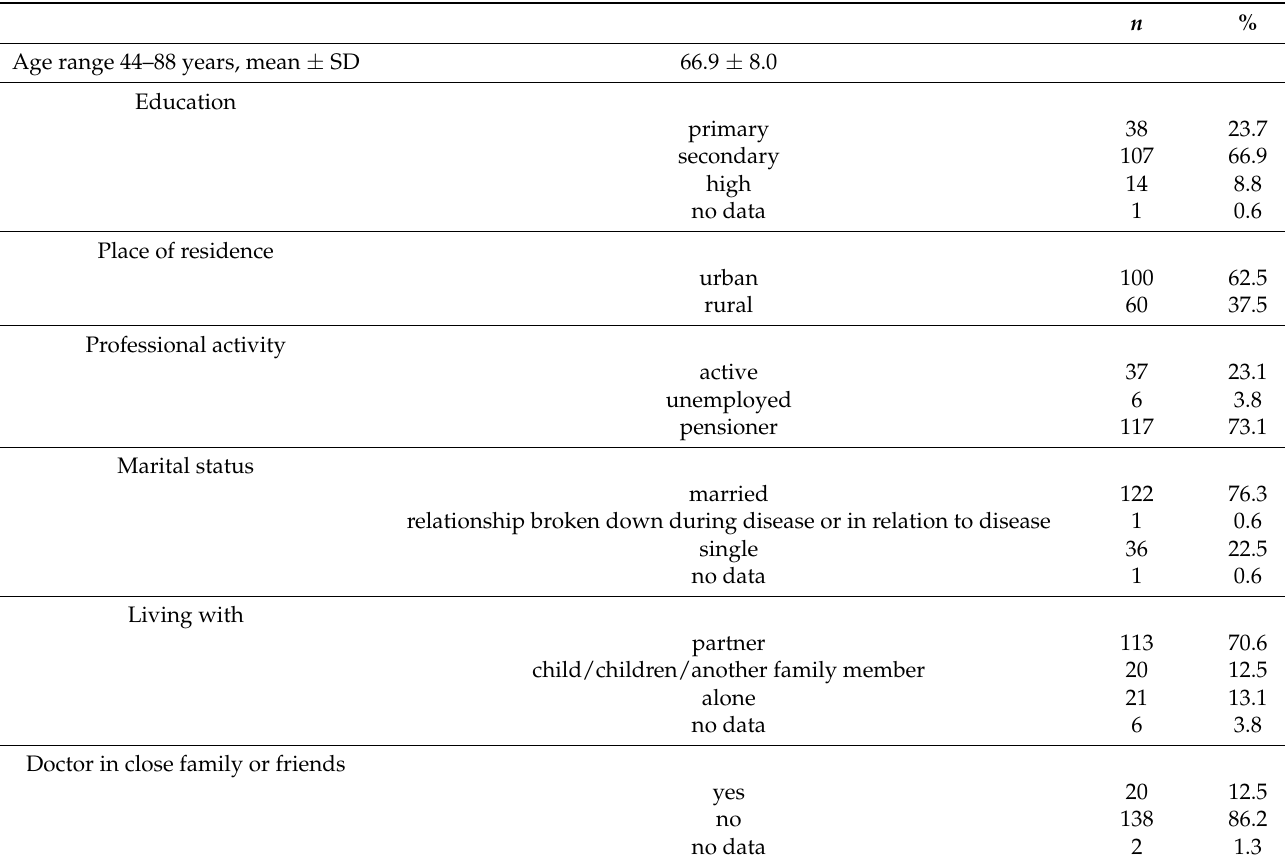
Table 1. Study group demographics.